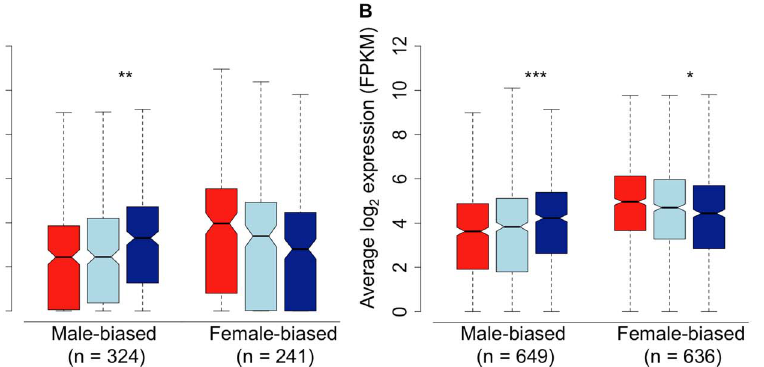
Figure 3. Sex-bias in the spleen of females (red), subordinate males (light blue) and dominant males (dark blue). Sex-bias was defined in panel A based on a 1.5-fold change threshold between females and dominant males, with a p-value , 0.05. Sex-bias in panel B is defined solely on statistical difference ( p , 0.05) between females and dominant males. Significant difference between dominant and subordinate males is indicated (Wilcoxon test, * p , 0.05, ** p , 0.01, *** p , 0.001, **** p ,